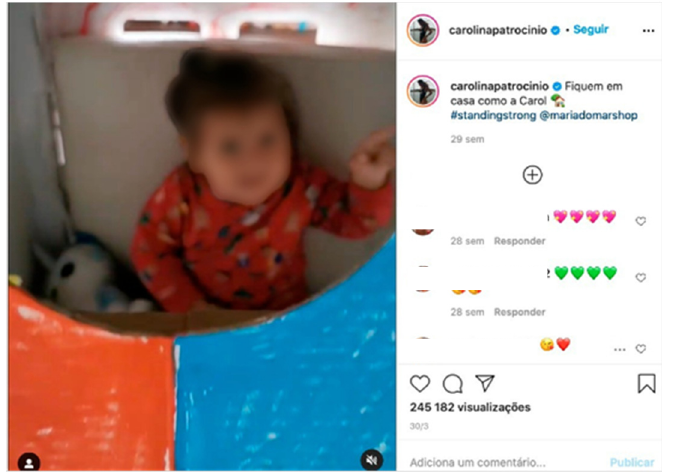
Figure 14. Example of speech “Advice or venting”; Instagram @carolinapatrocinio, Post, 30 March 2020.